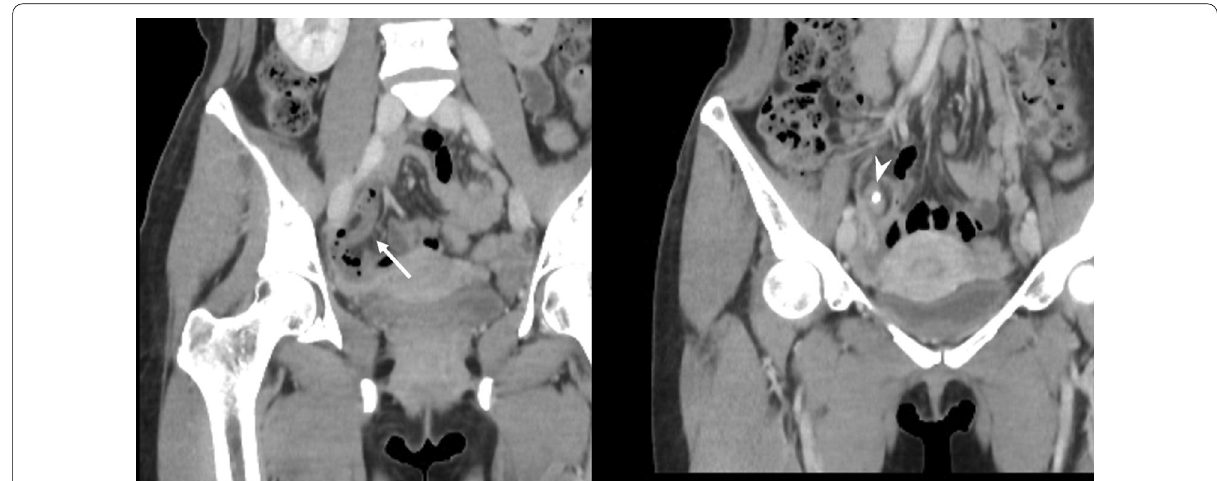
Fig. 2 Abdominal contrast-enhanced computed tomography findings after conservative treatment. The wall thickness and swelling of the appendix (white arrow) were improved. The fecalith (white arrowhead) remained near the root of the